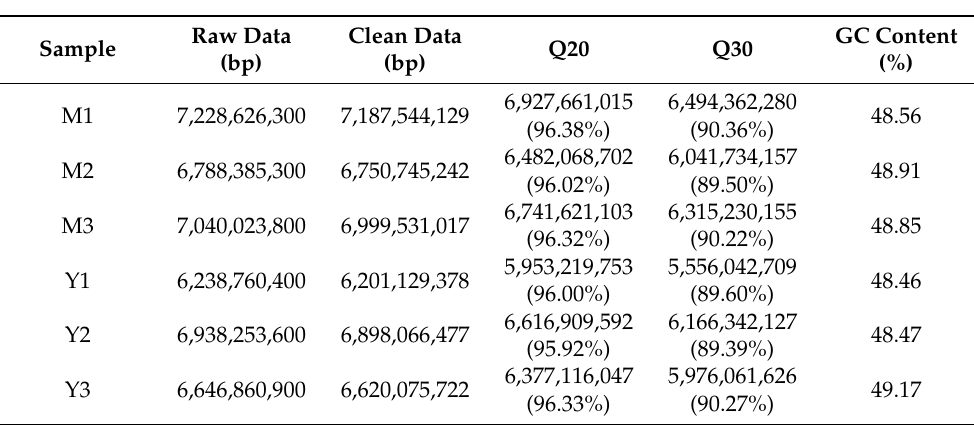
Table 3. Short-sequencing statistics of different